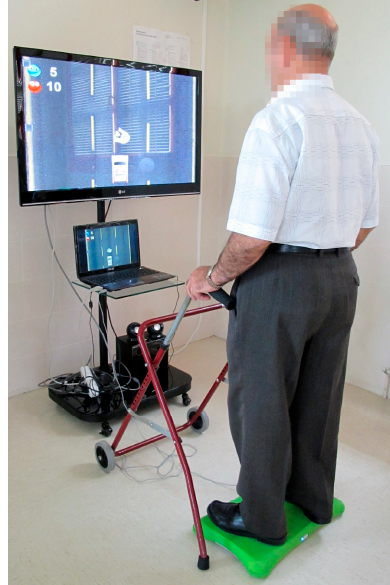
Figure 1. Patient interacting with the ABAR system.